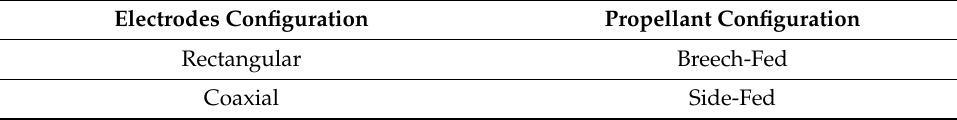
Table 1. PPT Table 1. PPT con fi gurations. Table 1. PPT con fi gurations.